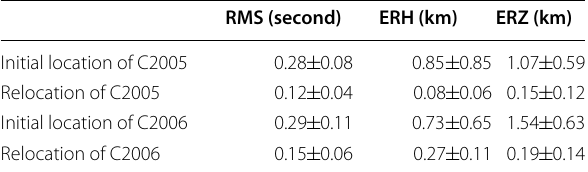
Table 1 The statistical error estimates of the averaged ERH, ERZ, and RMS from the initial location and the relocations in this study for the earthquake sequences detected by Networks 2005